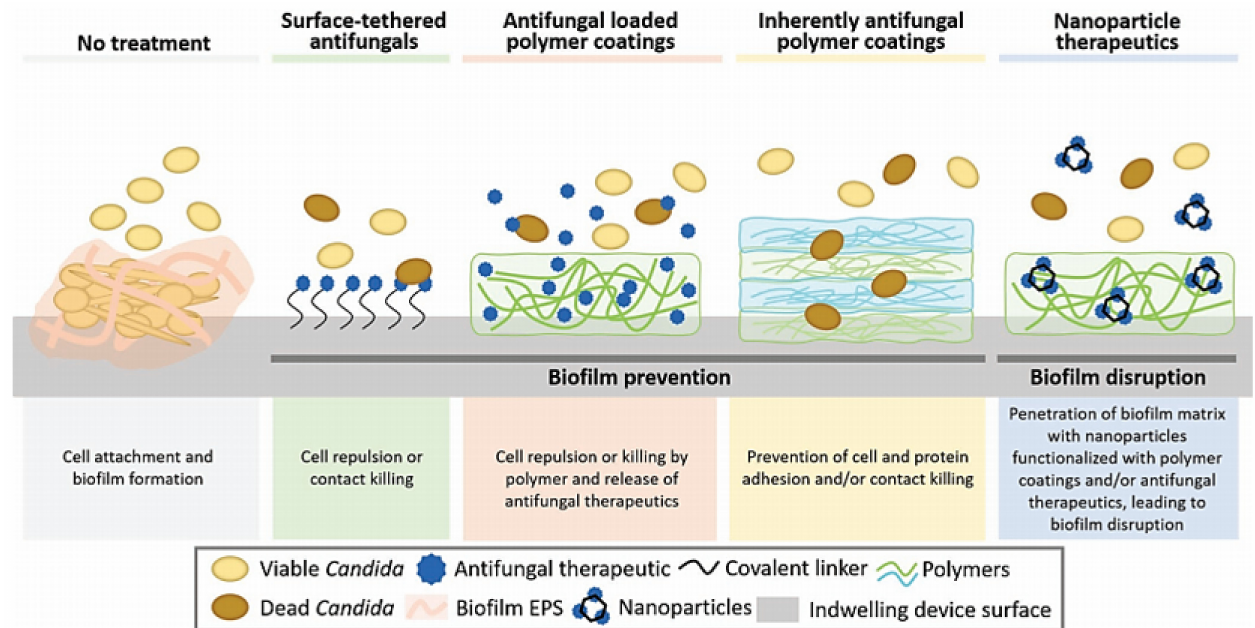
Figure 4. Schematic representation of different biomaterial strategies to combat surface-associated Candida biofilms. Reproduced from [21], Frontiers in Microbiology,